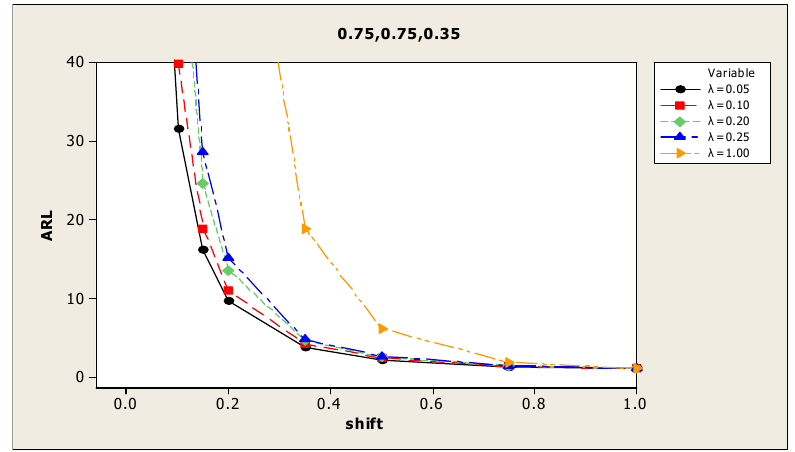
Figure 9. ARL curves when ρ yu = 0.7, ρ yv = 0.7, ρ uv = 0.35 at above values of λ